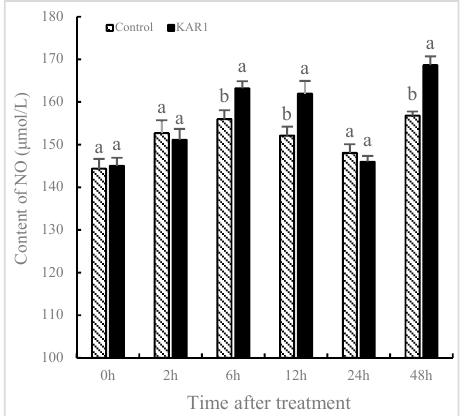
Figure 2. Time courses of NO level of S. miltiorrhiza hairy roots. The roots treated with KAR 1 were harvested at determined time points. NO contents of the root were then determined. Data are means of three replicates ± SD. Different letters indicate significantly different values according to one-way ANOVA followed by Tukey’s test ( p < 0.05).